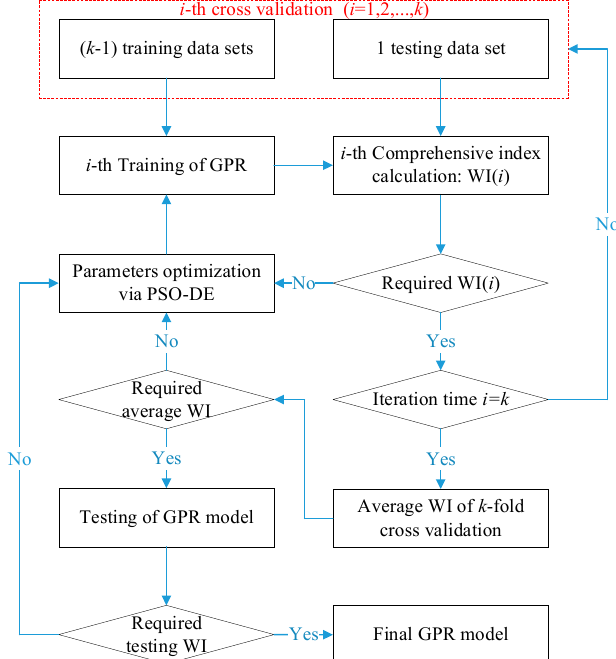
Figure 5. Diagram of GPR modeling procedure.